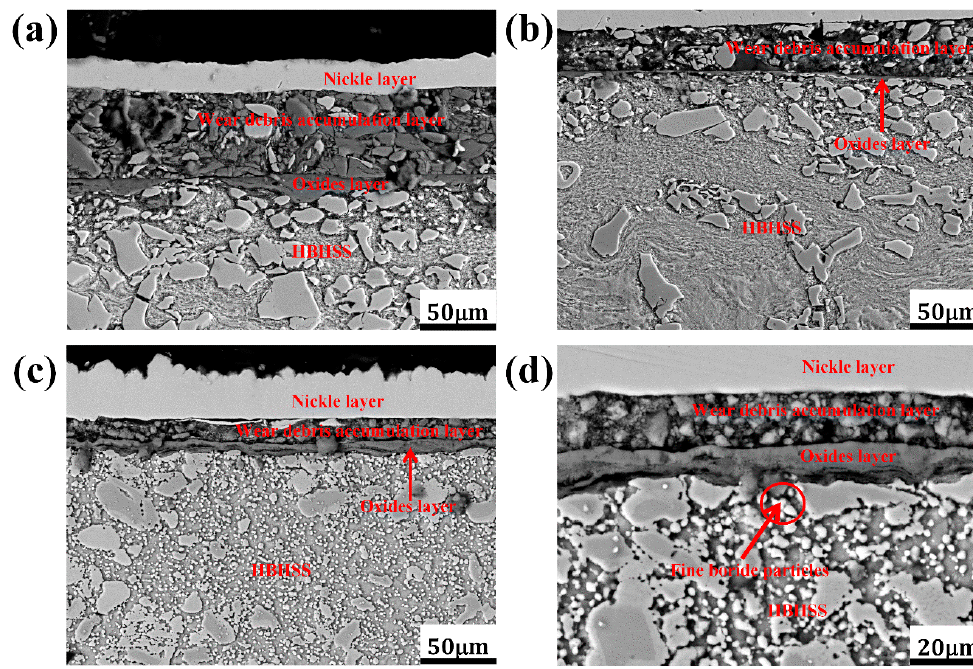
Figure 9. Cross-section morphologies of HBHSS with 4.8 wt.%Cr after oxidation wear at different temperatures and loads: ( a ) at 600 °C for 50 N, ( b ) at 600 °C for 100 N, ( c ) low magnification at 800 °C for 50 N, ( d ) high magnification at 800 °C for 50 N.